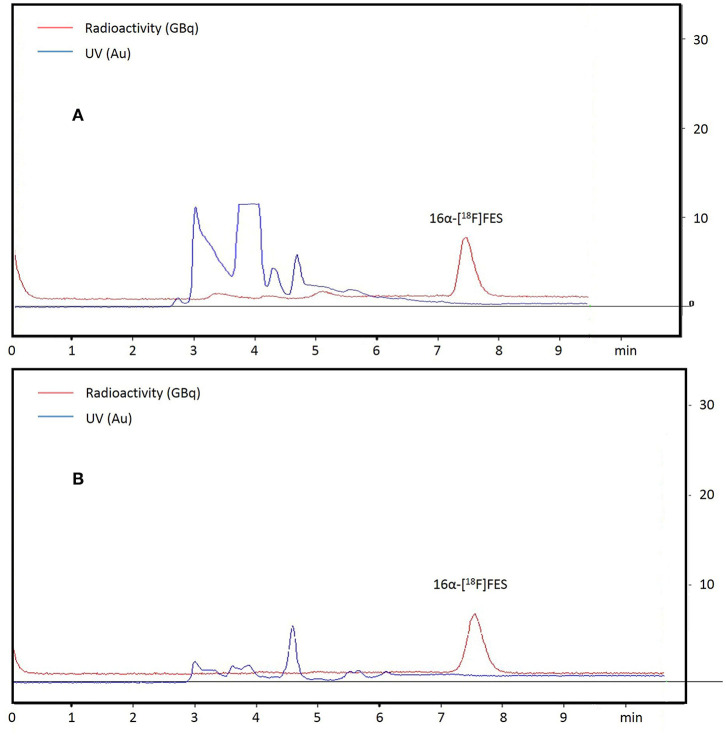
The semi-preparative chromatogram of crude 16α-[18F]FES, UV absorbance at 280 nm. (A) The chromatogram of the crude product (using K222/K2CO3). (B) The chromatogram of the crude product (using TBA·HCO3).